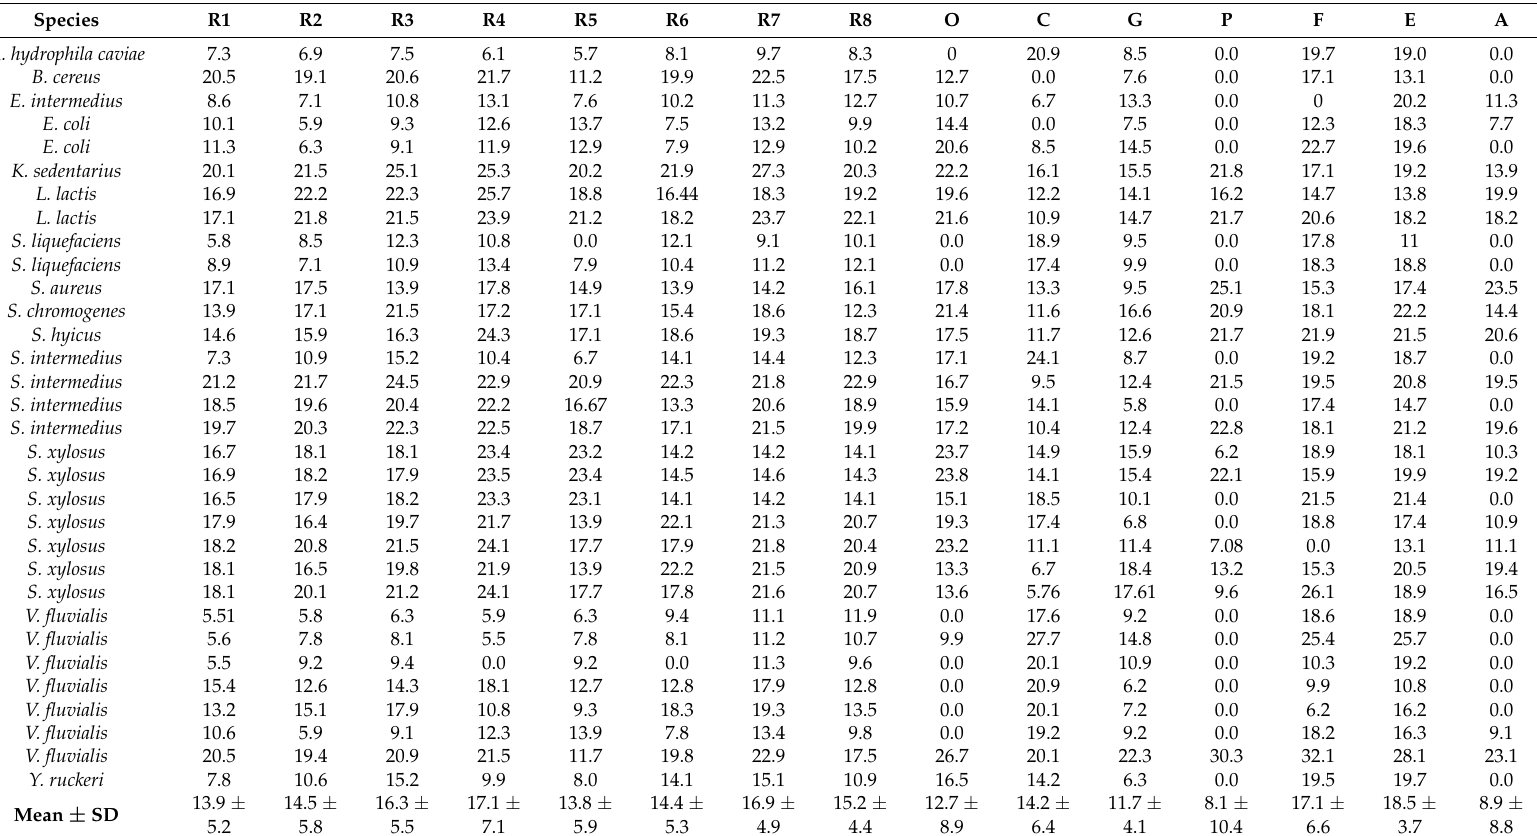
Table 4. Antimicrobial activity of developed products and antibiotics used, (mm, zone of